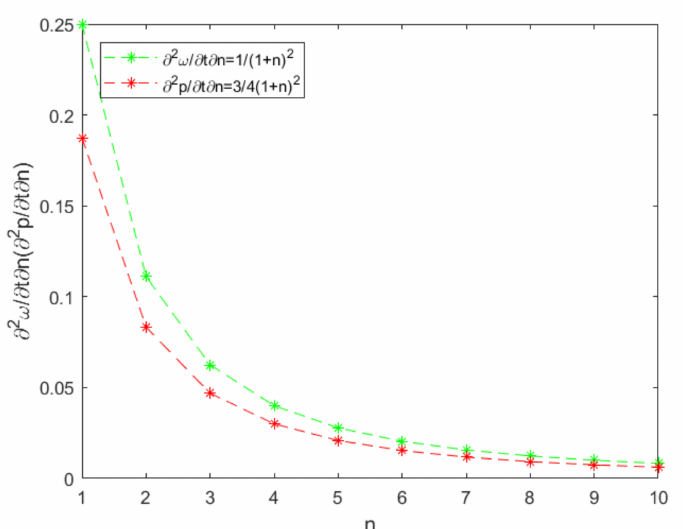
Figure 9. Relationship between the rate of change for products in upstream and downstream coun- tries with regard to changes in the specific duty and the degree of concentration in upstream countries.